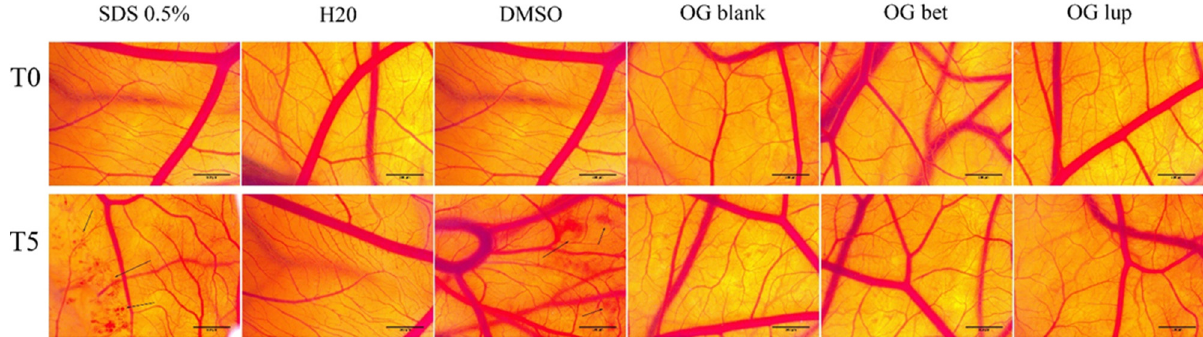
Figure 7. Analysis of the irritant potential of Blank OG, Bet OG, and Lup OG by the HET-CAM method. Stereomicroscopic images of CAMs inoculated with negative control—H 2 O, positive control—SDS, solvent used to solubilize OGs—DMSO 0.05% and test compounds 500 µg/mL. The black arrow indicates areas with massive bleeding in the case of SDS and DMSO.